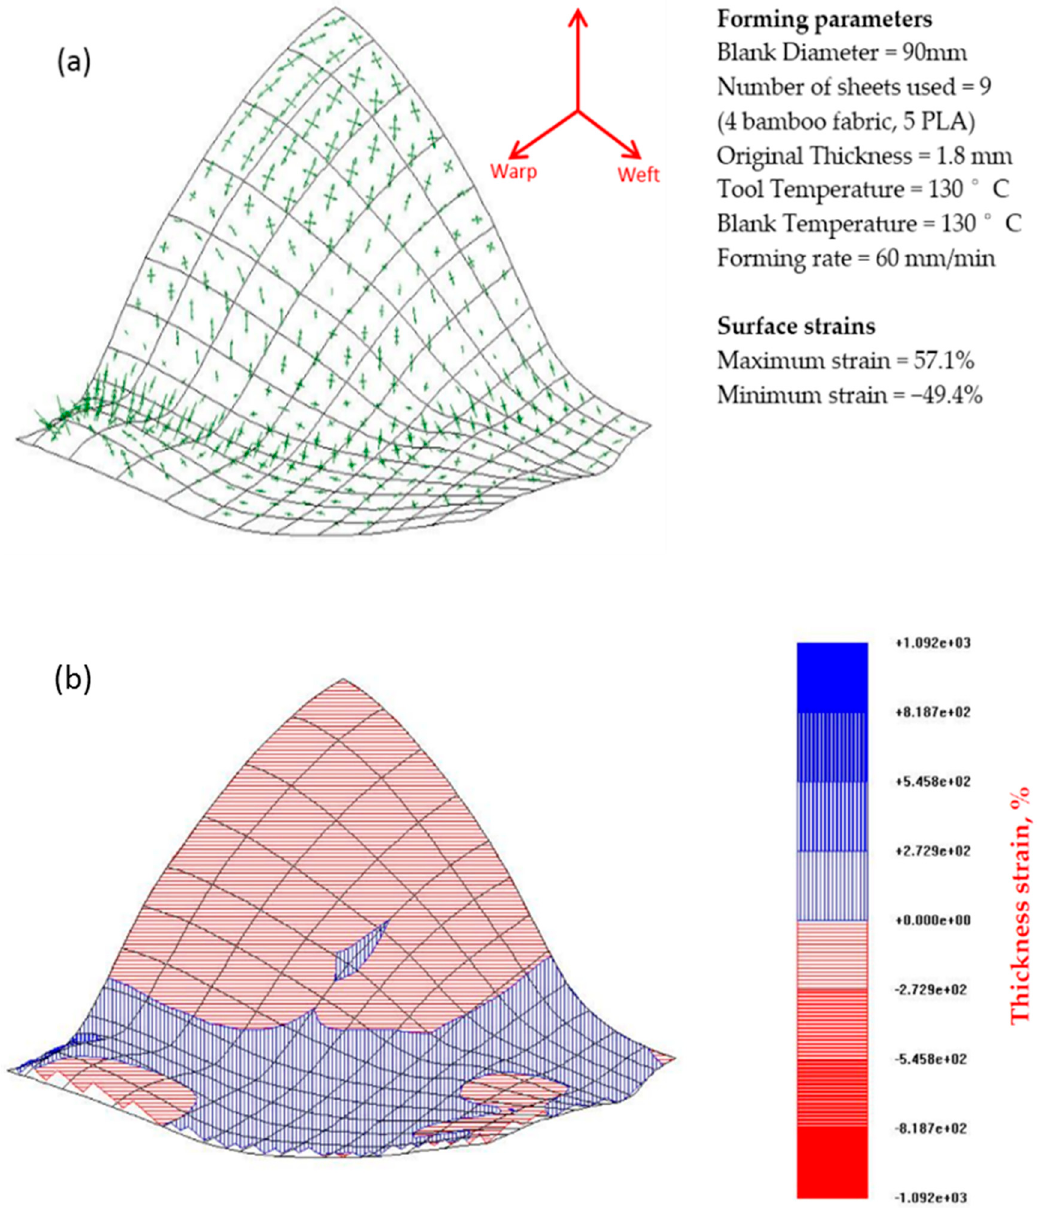
Figure 13. ( a ) Arrow diagram showing the surface strain map and ( b ) thickness strain contour plot for the bamboo fabric-PLA composite laminate of w/f/f/w layup formed using hot tooling conditions. Errors (mm): from 342 points, max = 2.54 Avg = 0.33.